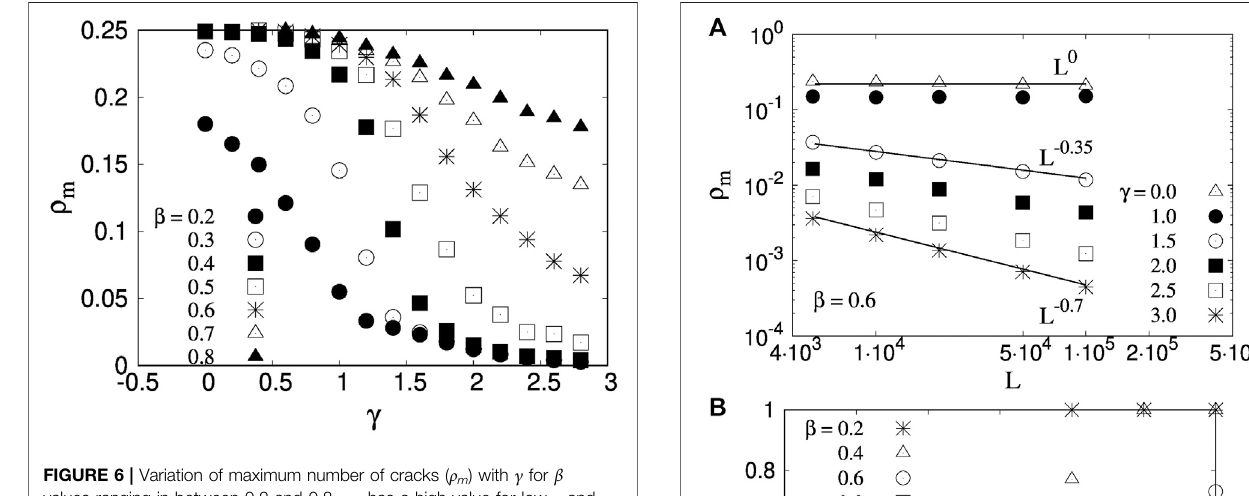
FIGURE 6 | Variation of maximum number of cracks ( ρ m ) with c for β values ranging in between 0.2 and 0.8. ρ m has a high value for low c and gradually decreases with c and tends to saturate towards a low value. For low β , ρ c , suggesting propagation of a m decreases close to 1/ L for high single crack. On the other hand, for low c and high β , ρ m ≈ 0.25, suggesting a failure process which is random in space.